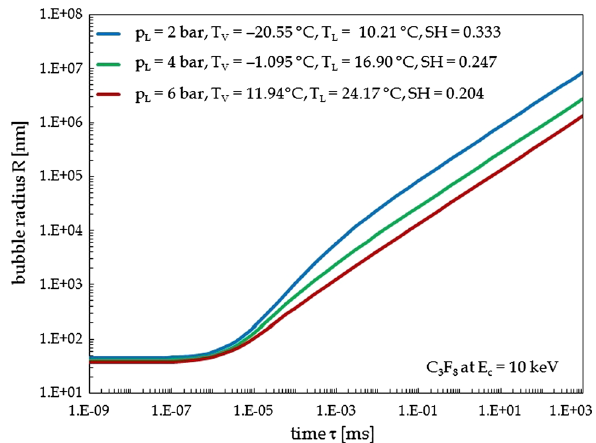
Fig. 1 Distributionsofthebubbleradius( R > R c )vs.timeat E c = 10 keV using p L as a parameter